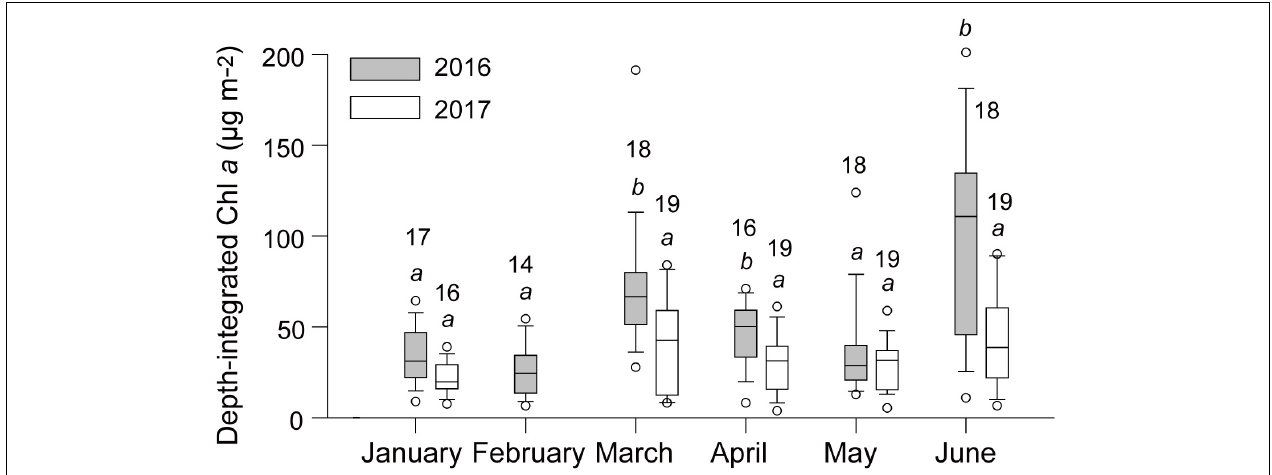
FIGURE 2 | Seasonal and interannual variability in depth-integrated chlorophyll a (Chl a ) concentrations. The box and whisker plots represent the median values (horizontal line in the boxes) and the smallest (10%) and largest (90%) values. The same letters indicate no significant difference among medians as determined by a Kruskal–Wallis test followed by Dunn’s post hoc multiple comparison